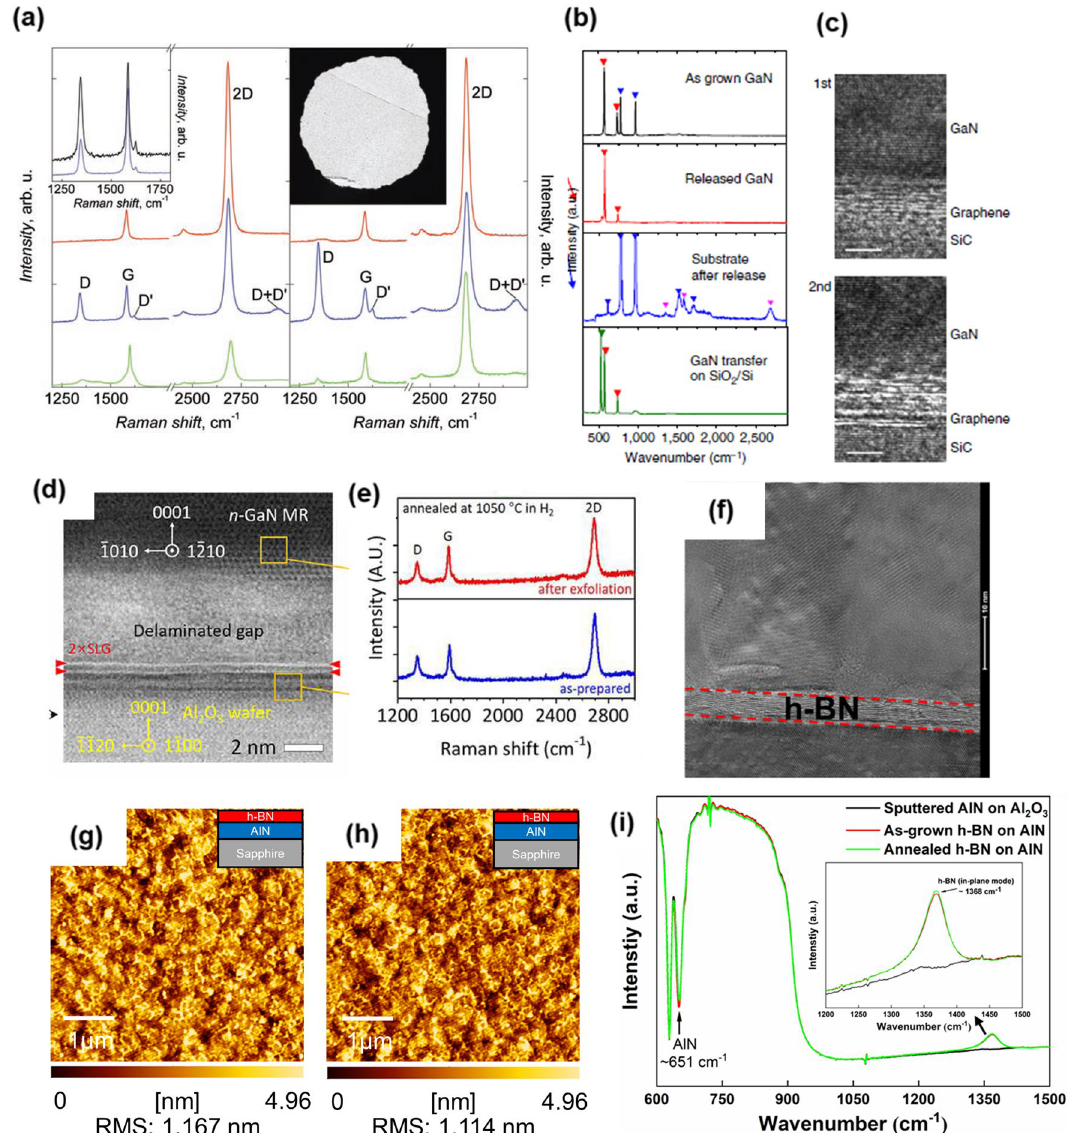
Fig. 8 Effect of hydrogen on 2D materials. a Changes in Raman spectra of graphene caused by hydrogen. Left is Graphene on SiO 2 and right is free‑standing graphene. Red, blue, and green curves correspond to pristine, hydrogenated, and annealed samples, respectively. Figure reproduced from ref. [212], AAAS. b Raman spectra taken from an as‑grown GaN film on graphene/SiC, released GaN films on the tape, remaining graphene after GaN release and GaN film transferred on SiO 2 substrate. c HRTEM observed at the interface between GaN and SiC showing graphene remains after growth. Top image is GaN grown on a fresh graphene/SiC and bottom image is GaN grown on a reused graphene/SiC substrate. Figure reproduced from ref. [8], Springer Nature Ltd. d STEM image of GaN grown on graphene/c‑sapphire confirming graphene remains. e Annealing test of wet‑transferred graphene on c‑sapphire at 1050 ºC ambient in H 2 . Figure reproduced from ref. [199], AAAS. f high‑magnification CCD image of the interface between AlN and c‑sapphire confirming the presence of h‑BN layer. Figure reproduced from ref. [213], Elsevier. g 5 nm‑thick h‑BN layer as grown on AlN. h annealed h‑BN on AlN at 1400 ºC ambient in H 2 . i FTIR spectra for confirming the presence of h‑BN after annealing. Figure reproduced from ref. [203], RSC